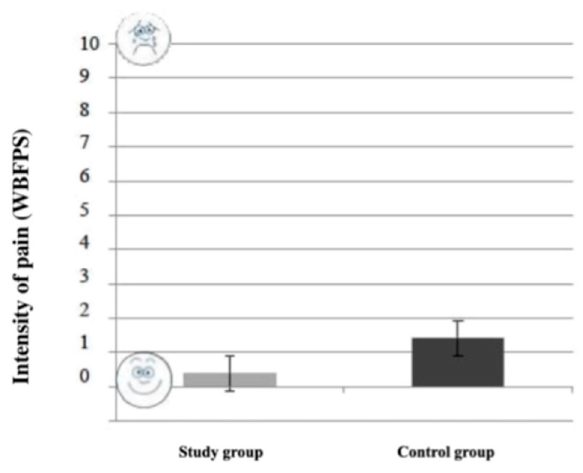
Figure 3. Reported pain by children in the two groups. Figure 3 . Reported pain by children in the two groups .